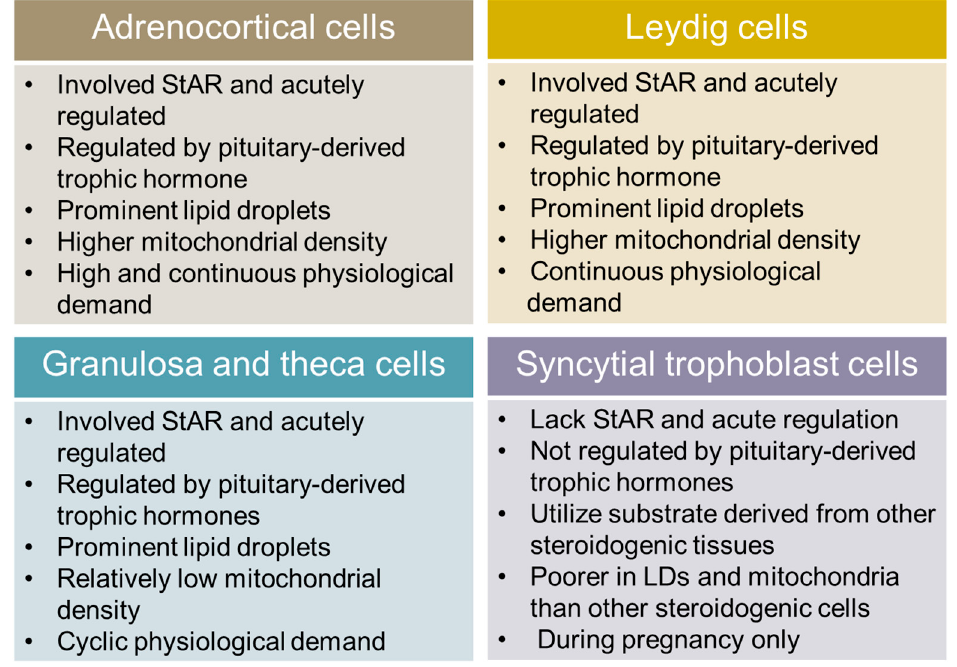
Figure 1. Similarities and differences between major steroidogenic cells in relation to physiological demand and cellular structure pertaining to lipid droplets and mitochondrial structure/content.